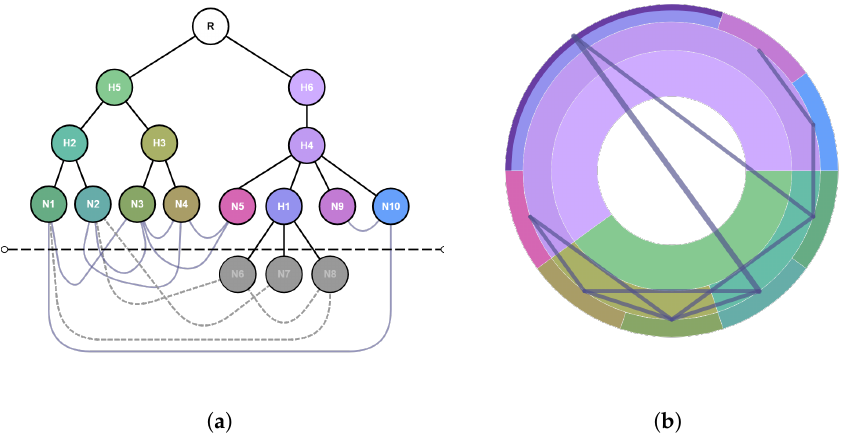
Figure 5. Hierarchy pruning by depth selection: ( a ) Limiting the depth of the visible tree to 3 levels implies eliminating the descendant nodes of H1 from the visualization. ( b ) Their connections are aggregated in the meta-connection incident on the meta-node H1, while the highlighted outer arc indicates the existence of non-visible